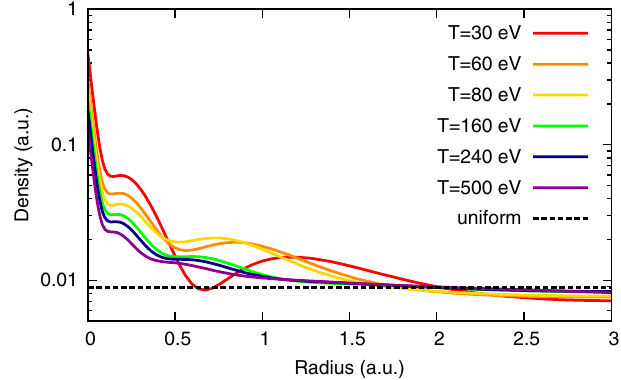
FIG. 4. Free-electron density of aluminum plasma for different temperatures, obtained from the first step of our two-step